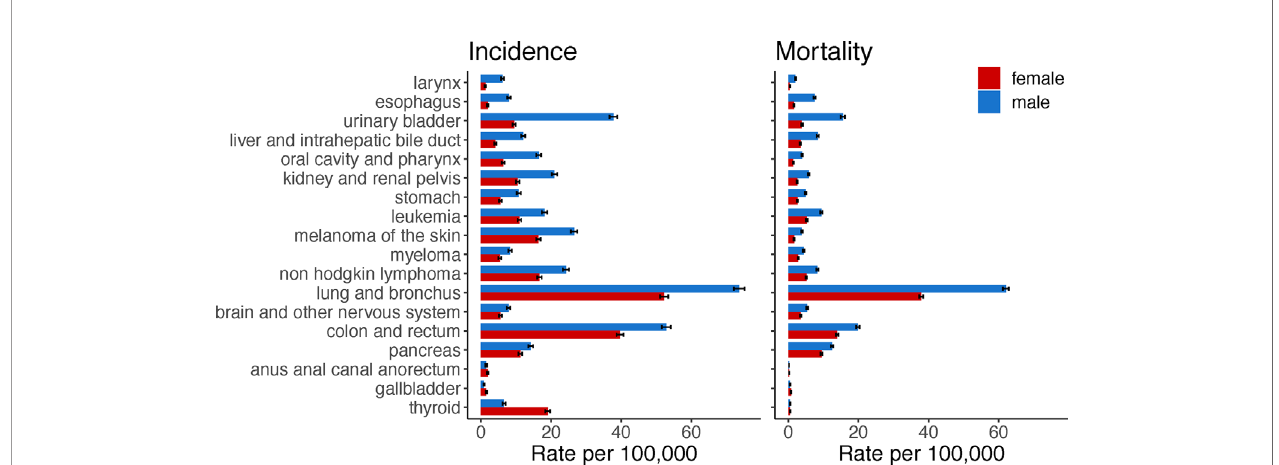
FIGURE 1 | Cancers with sex disparity in incidence and mortality rates. Age-adjusted incidence and mortality rates per 100,000 individuals in the US were retrieved from the Surveillance, Epidemiology, and End Results explorer. Bars show the average rate from 2000 to 2017 and 95% con fi dence interval. Cancer sites are ordered according to the male-to-female incidence rate ratio; starting from cancer sites with higher incidence rates in males compared to